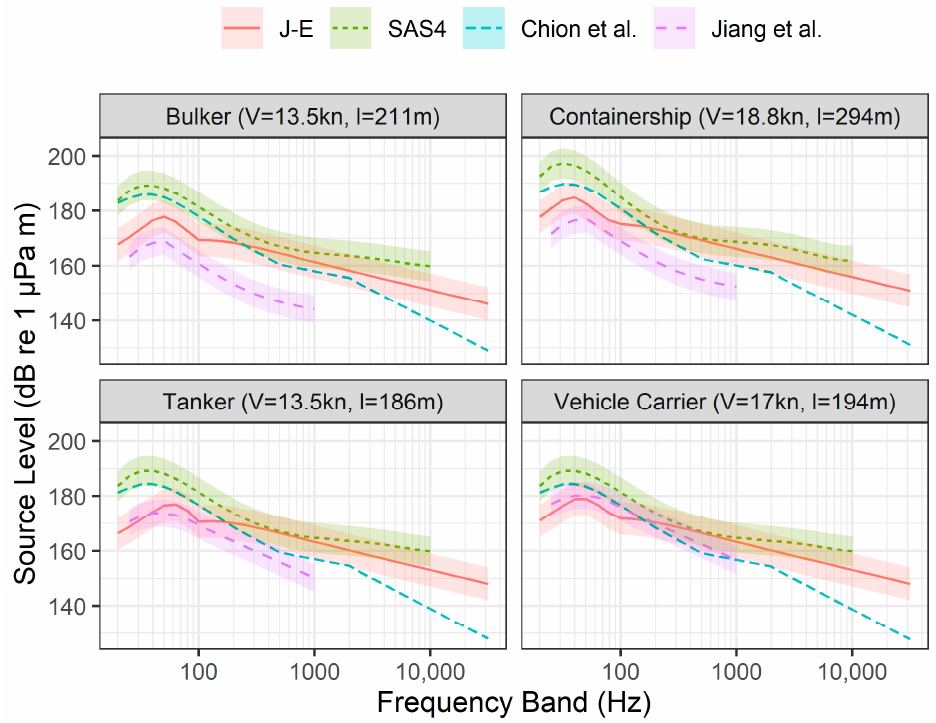
Figure 7. Decidecade band source levels predicted by the JOMOPANS-ECHO model (J-E) compared with three other recent source level models. Predictions are shown for four representative merchant vessels, with mean length (l) and speed (V) from the ECHO data set. Lines correspond to different models as follows: J-E is the model from this work, SAS4 is the simple AS 4 model from ref [26], Chion et al. is the model from ref [31], and Jiang et al. is the model from ref [27]. Color-shaded areas indicate the model uncertainties, where reported ( ± one estimated standard deviation, assuming normal distribution of